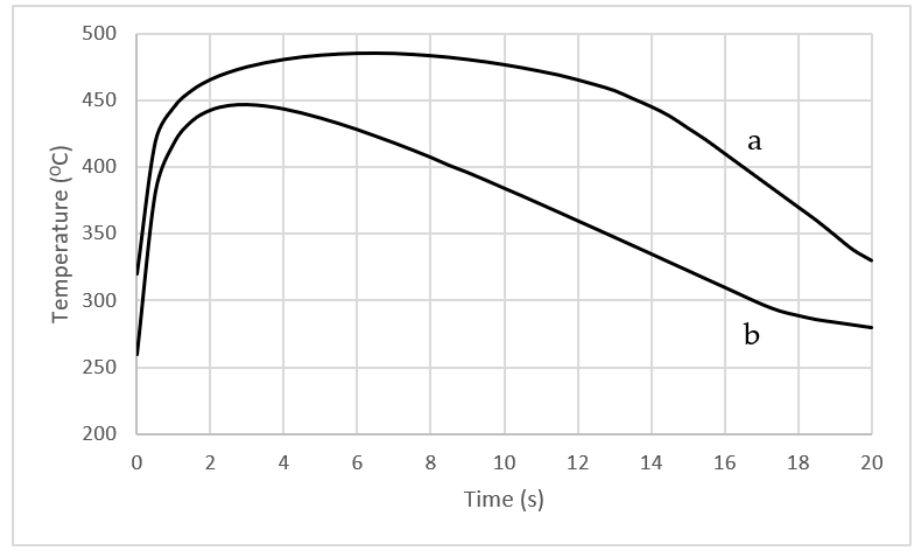
Figure 7. Temperature variation as a function of time numerically determined for Point “A” (Figure 6) in cores: (a) with a conventional cooling channel; (b) with a conformal cooling channel.